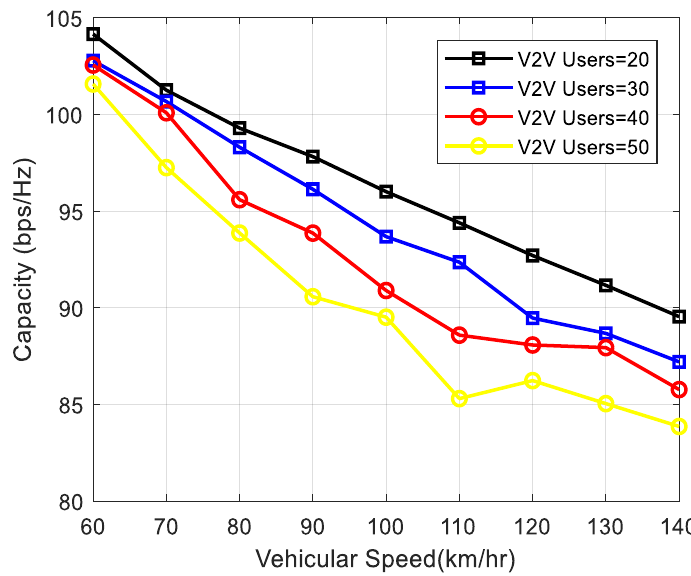
Figure 8. Vehicular speed vs capacity with different numbers of V2V users.